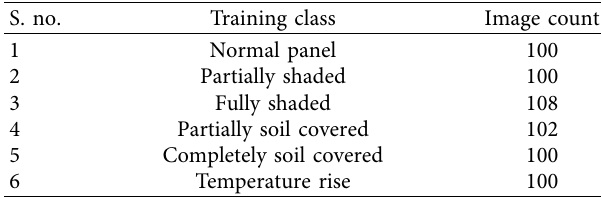
Figure 5: Confusion matrix.